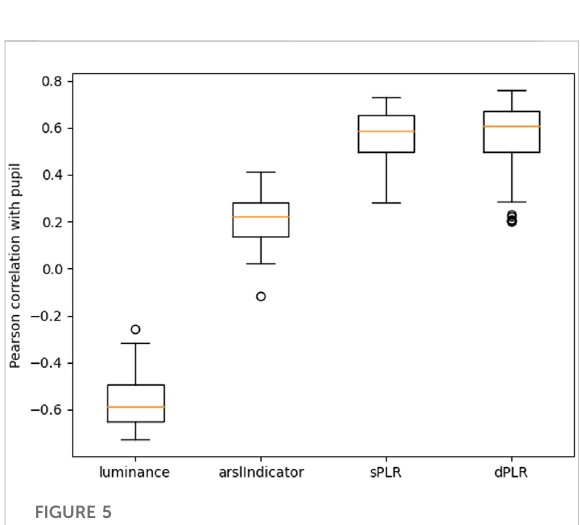
FIGURE 5 Pearson correlation coef fi cient of measured pupil with the: luminance, arousal indicator, PLR using exponential model (sPLR), PLR using dynamic model (dPLR). All the correlation distributions are statistically signi fi cantly different from each other (paired Wilcoxon test with p-value less than 0.001) except sPLR and dPLR.